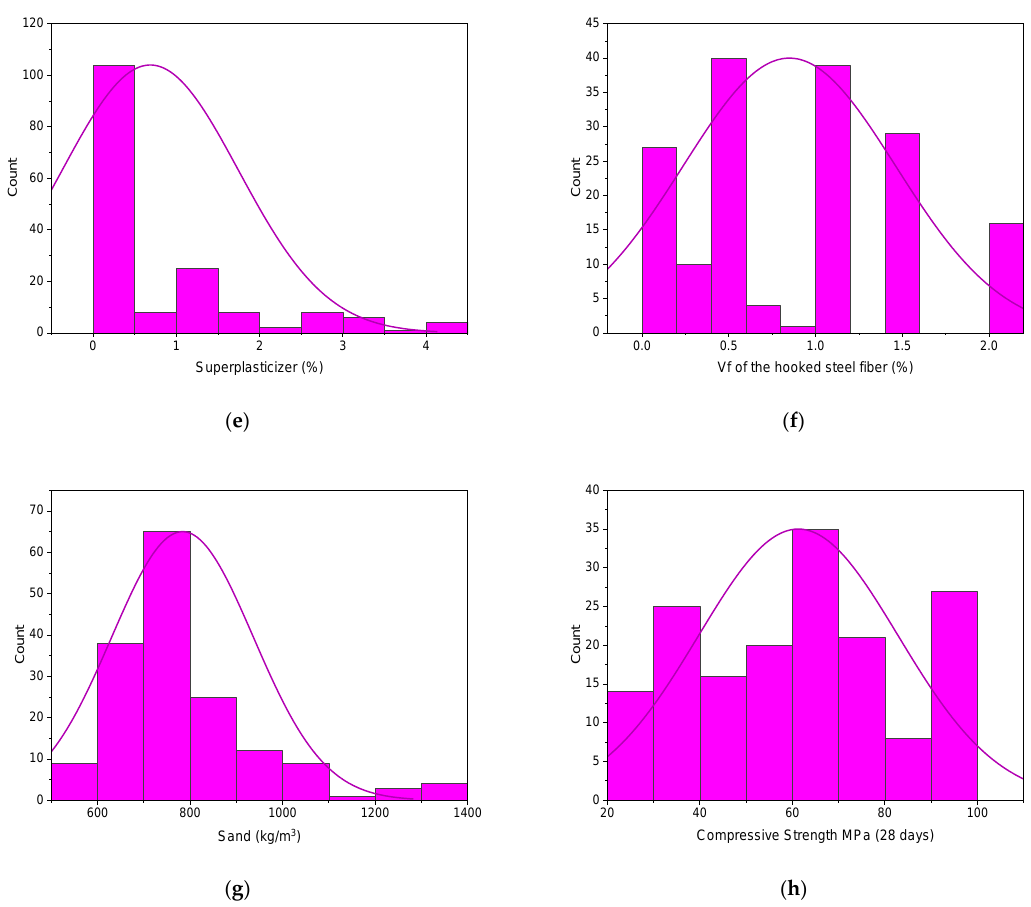
Figure 1. Relative frequency patterns of input and output factors: ( a ) cement; ( b ) coarse aggregate; ( c ) silica fume; ( d ) water; ( e ) superplasticizer; ( f ) volume fraction of steel hooked fibers; ( g ) sand; and ( h ) compressive strength.